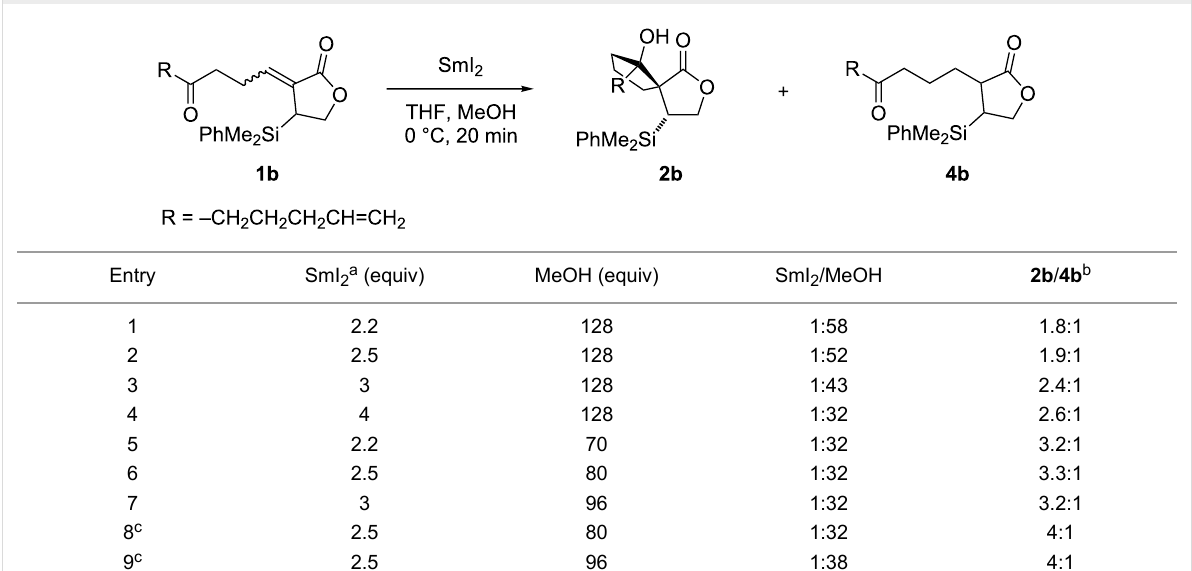
Table 1: Optimisation of SmI 2 –mediated spirocyclisation